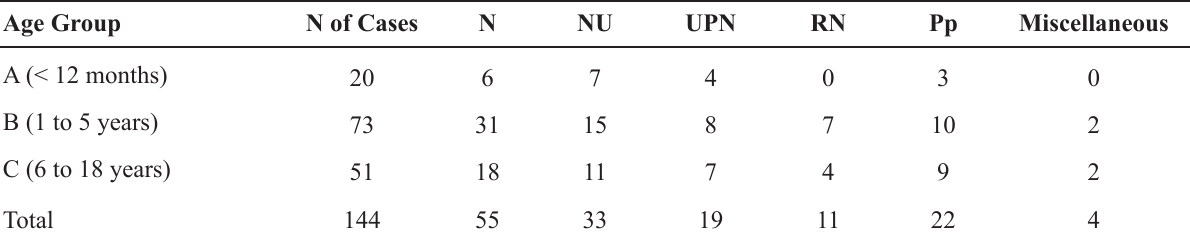
Table 2 – Number of procedures performed in each age group. Age Group